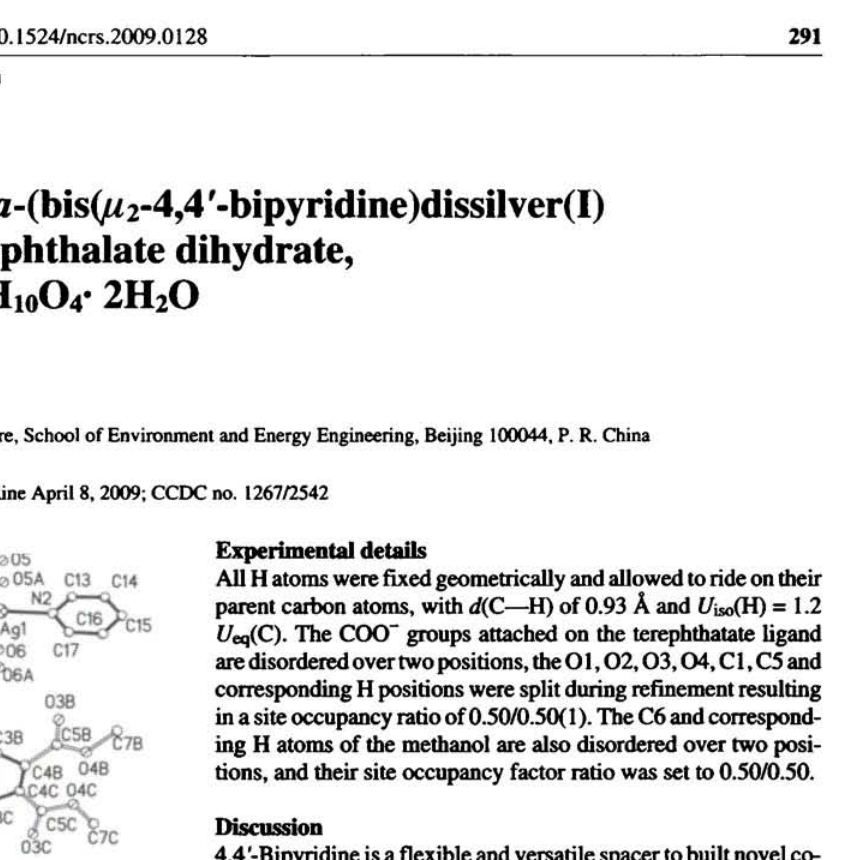
Table 1. Data collection and handling. Crystal: